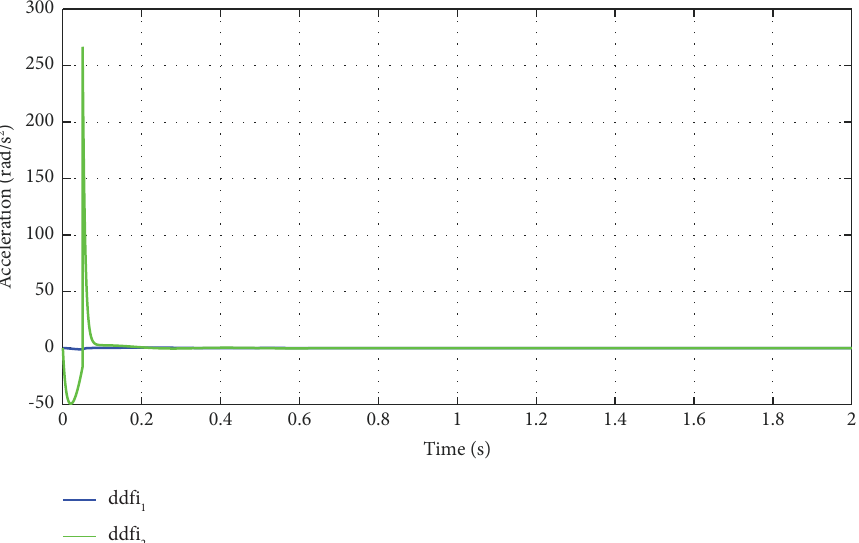
1 -angular acceleration of the truck body